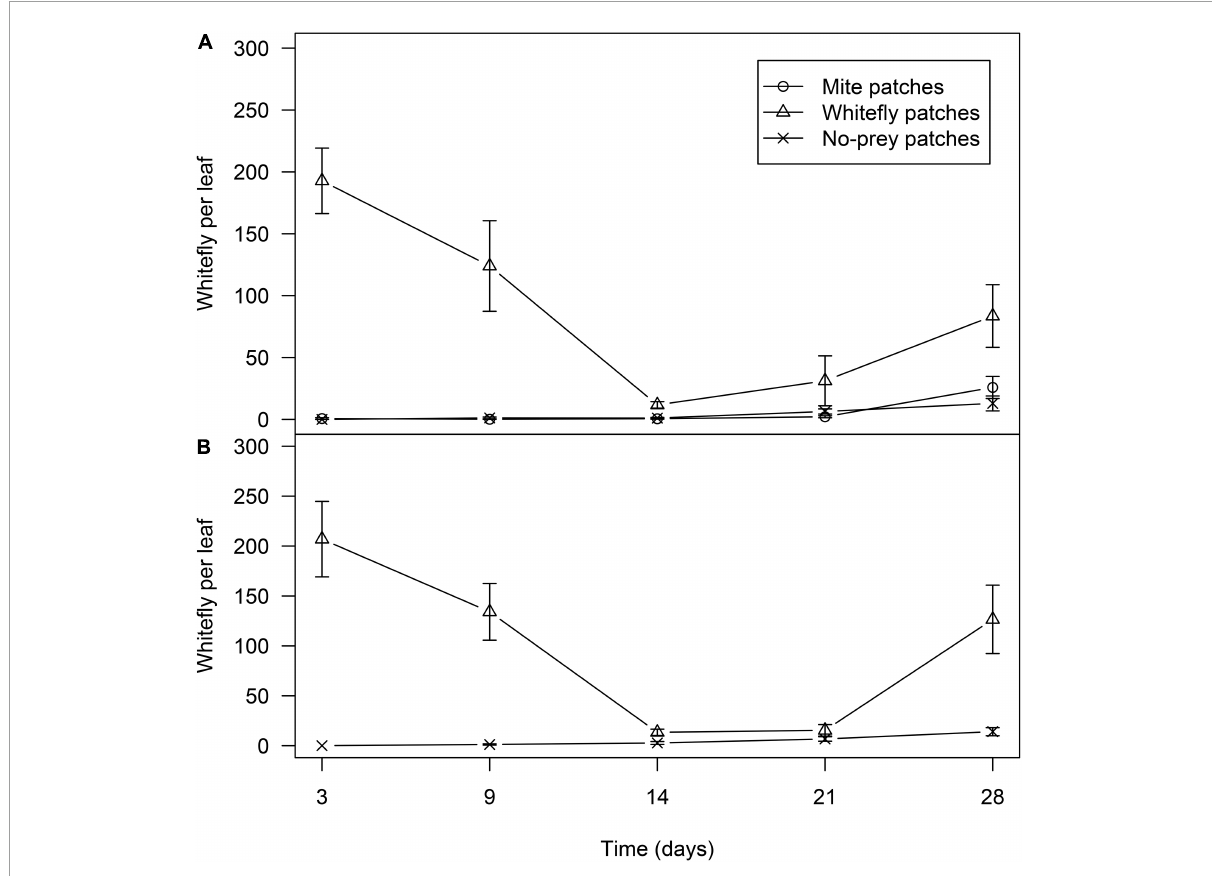
FIGURE9 Average of whitefly scales (nymphs+pupae) with standard error in no-prey, mite and whitefly patches in mixed-prey (A) and whitefly habitats (B)